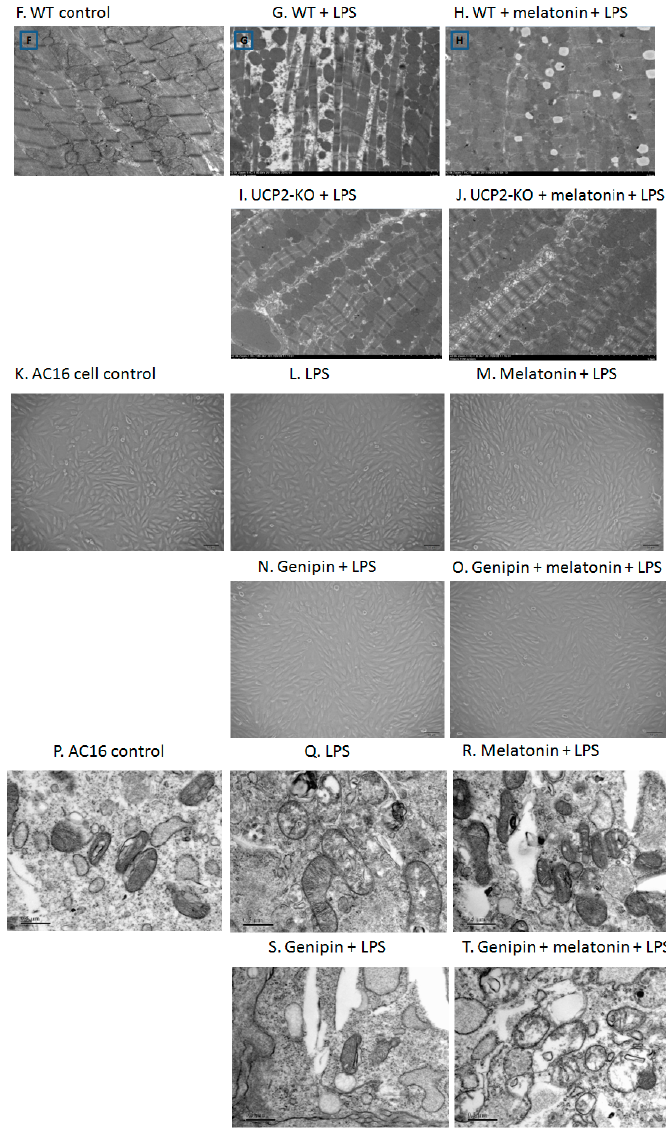
Figure 2. Observation on morphological alteration in heart tissues of animal models or in vitro culture of AC16 cells. Panels ( A – E ): H&E staining and histological observation of the heart tissues. Magnification: ×40. Panels ( F – J ): Transmission electronic microscopic observation of the heart tissues. Magnification: ×200 Panels ( K – O ): Morphological observation of AC16 cells under